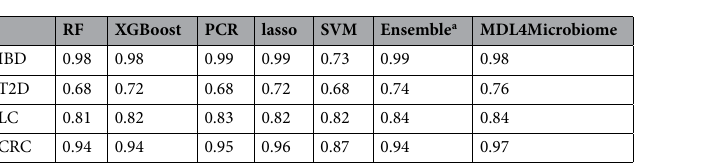
of contigs classified to the same taxon at the family and genus levels. Over 86% of the clusters had their longest sequences assigned to the dominant taxa in the cluster. This indicates that the clustering and selecting the longest contig from each cluster for representative contigs works properly to generate genomic features. The classifier was also trained with metabolic function features obtained using the KEGG database (see “Methods” “Construction of multimodal deep learning model”). Using a probability threshold of 0.5, the model achieved an accuracy of 79.5%, 70.3%, 77.4%, and 94.1% for the IBD, T2D, LC, and CRC datasets, respectively (Table 2). Even though the accuracy with metabolic function features alone was lower than the compositional features (i.e., taxonomic, and genomic features) except for the CRC dataset, the combined features increased the